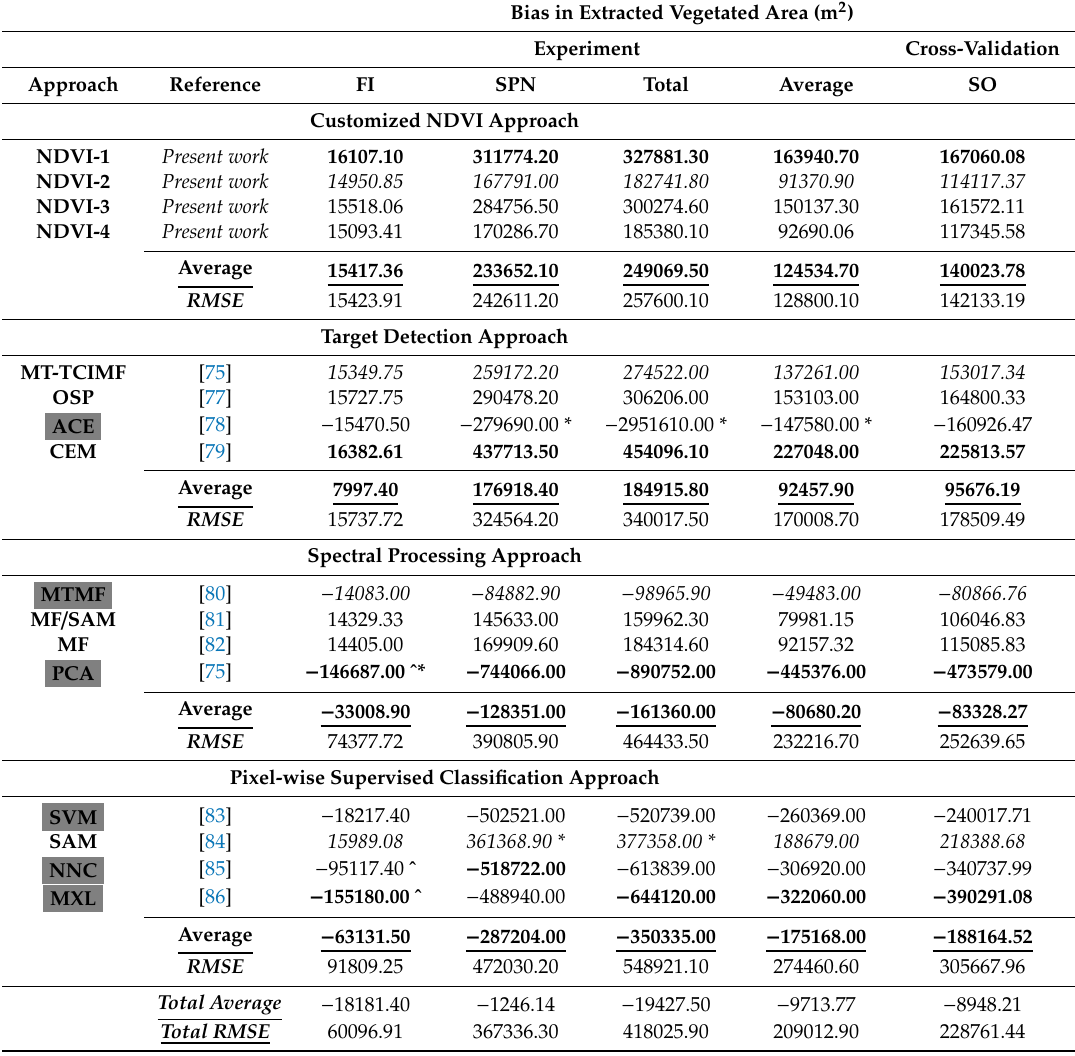
Table 4. Quantitative evaluation of various feature extraction methods for extracting vegetation from Fisher Island (FI), Stornes Peninsula (SPN), and cross-validation with Schirmacher Oasis (SO) in terms of bias in extracted vegetated area (m 2 ). The lowest ( italics ) and highest (bold) values in each local column are highlighted. The column-wise average values are in bold and underlined. Methods that cause overall overestimation (negative bias values) of vegetation are highlighted with the grey background colour. Global outliers (with respect to all 16 methods) are highlighted with ˆ marks while local outliers (with respect to the four methods in the approach) are highlighted with *